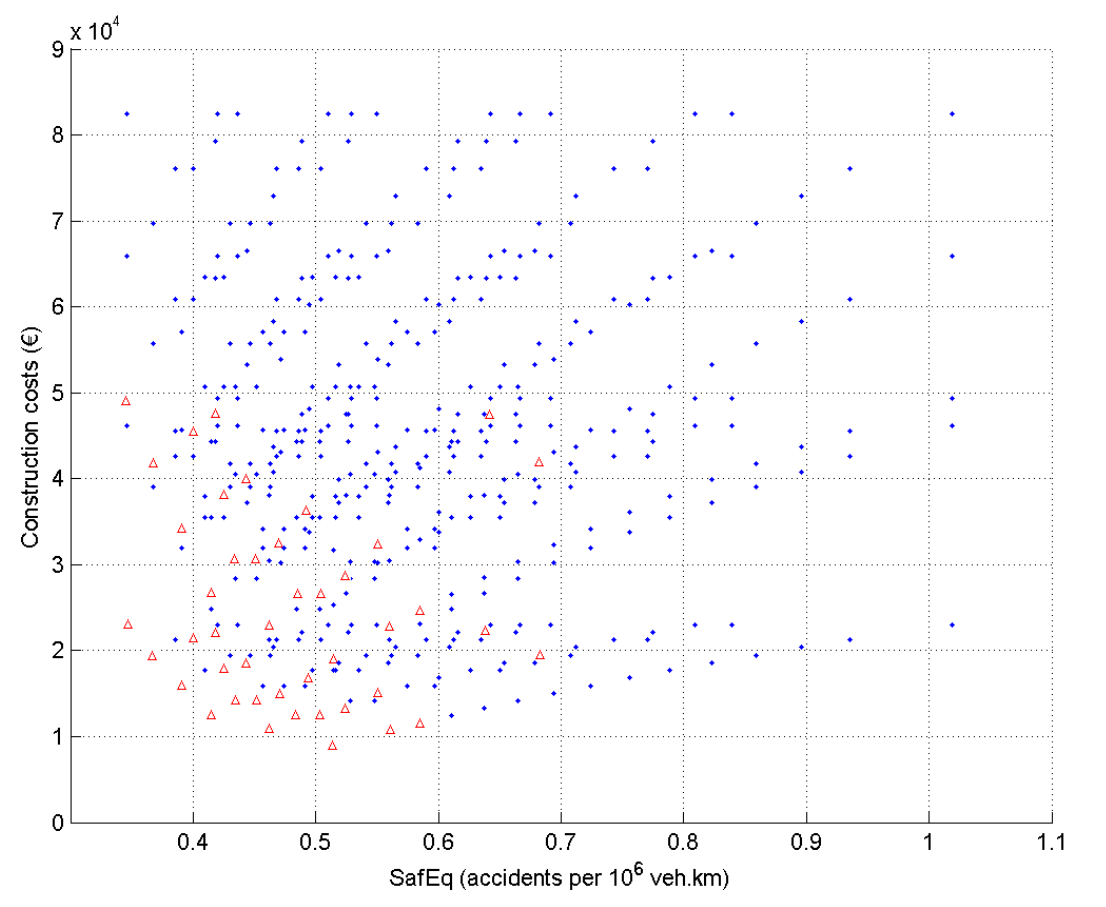
Figure 5. two-axis projection view of the dominated and non-dominated